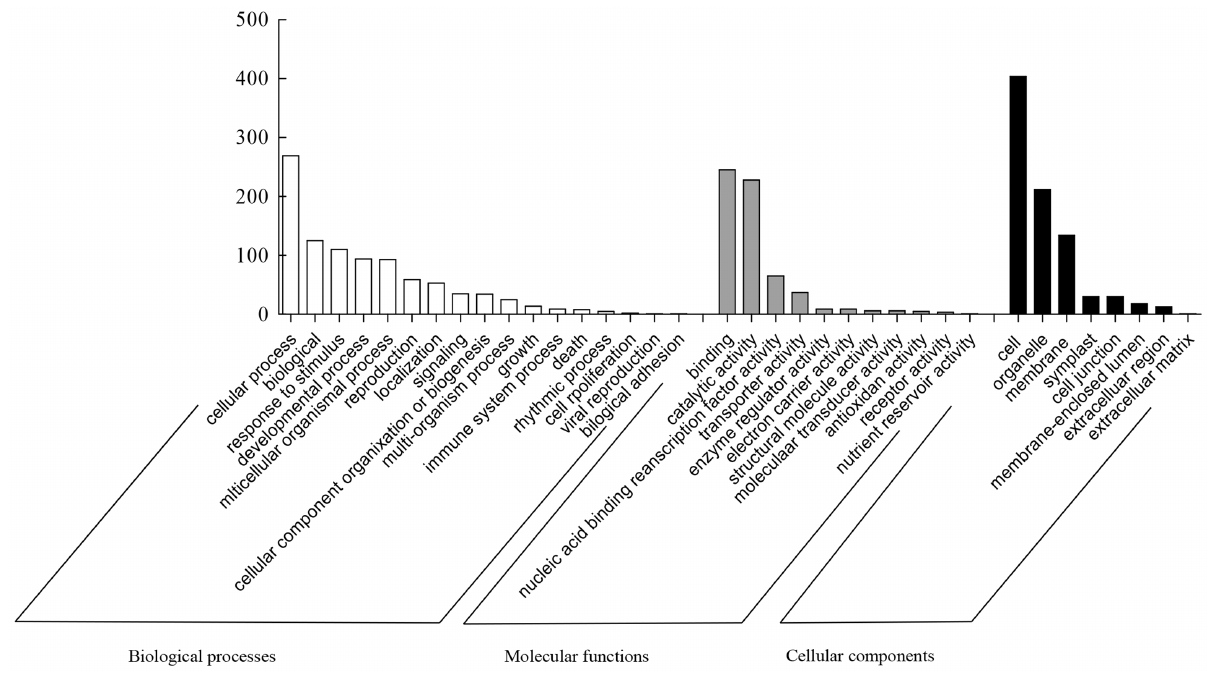
Figure 2. GO analysis of the conserved miRNA target candidates. The potential targets of miRNAs were predicted with psRNATarget by alignment to mRNAs from Oncidium, Oryza stativa and A. thaliana . The best hit results were chosen and annotated using Blast 2 GO.